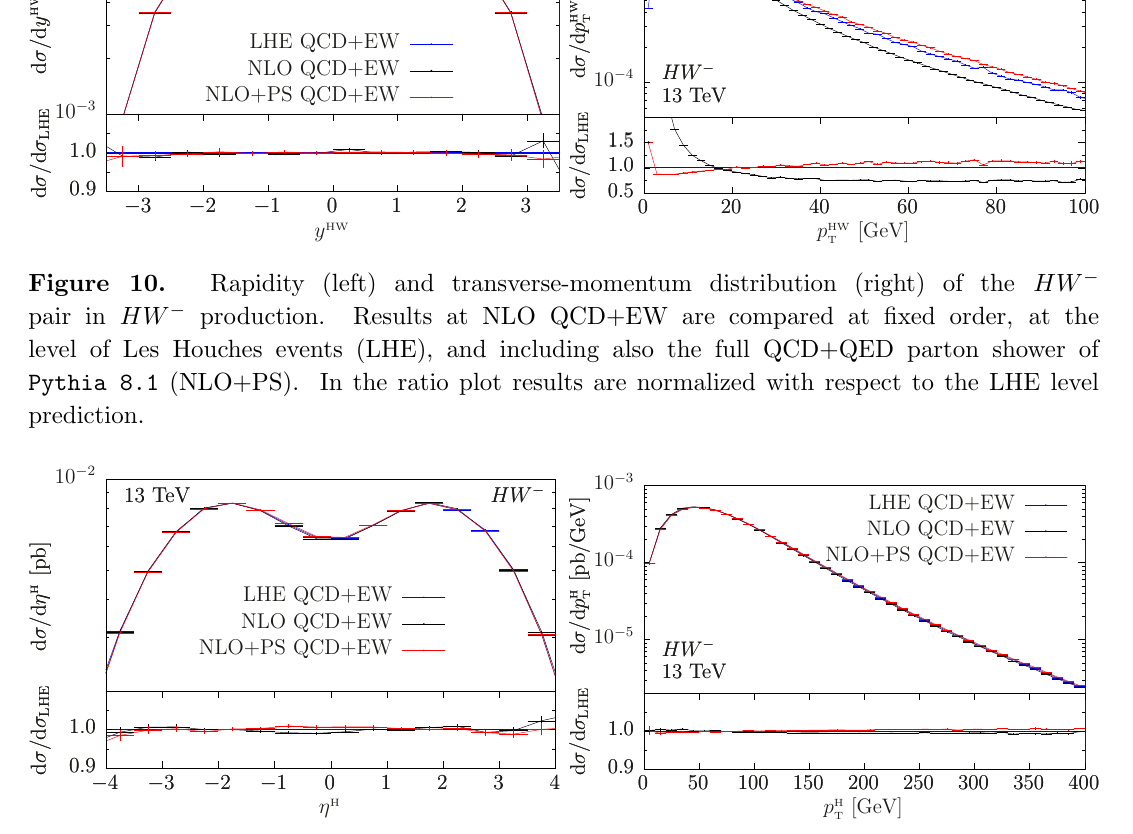
Figure 11. Pseudorapidity (left) and transverse-momentum distribution (right) of the Higgs boson in HW (cid:0) production. Same curves and labels as in (cid:12)gure